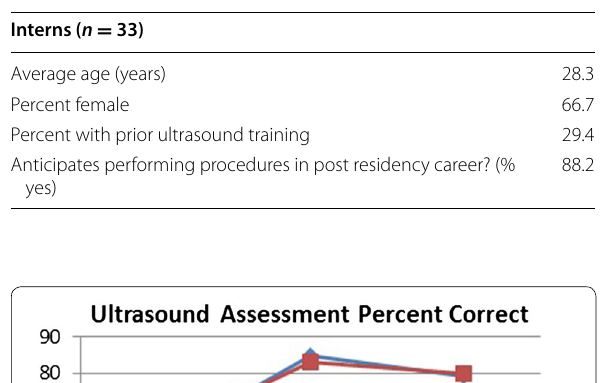
Table 1 Demographics of interns participating in “inten-